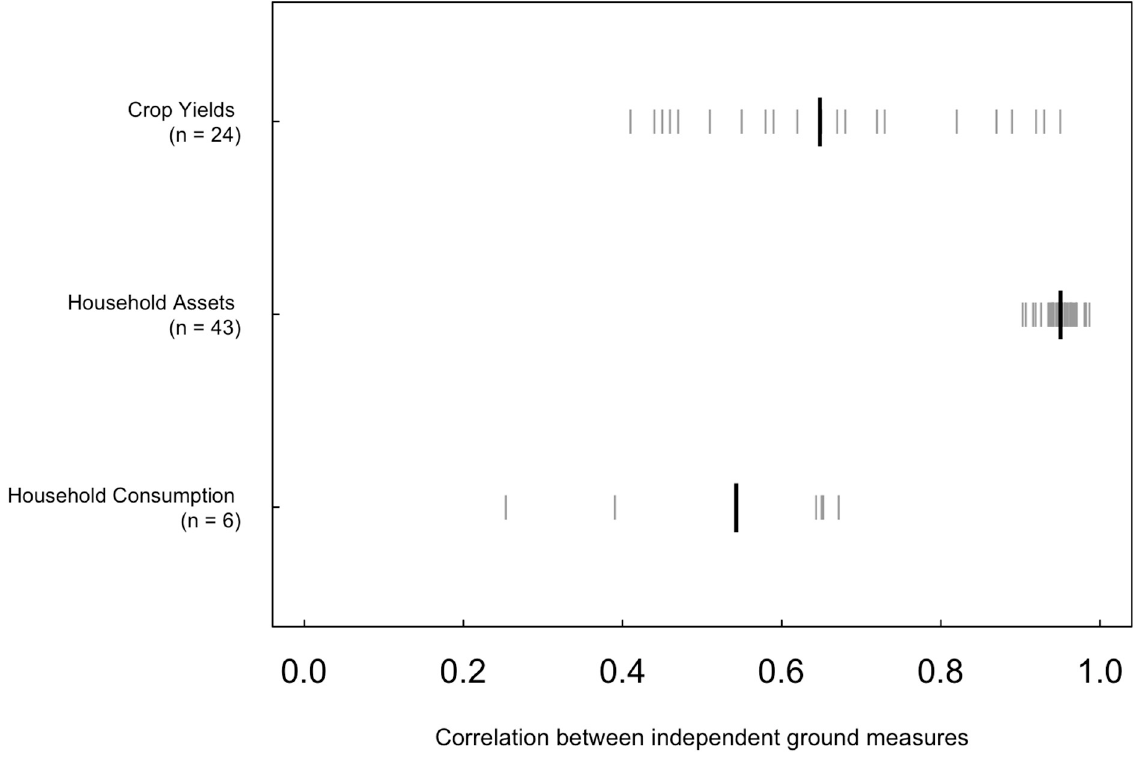
Figure 1. Noise in ground-based measures can lead to low correlations between independent measures in the same location. Gray lines show estimates of the correlation between two independent measures, with one line for each separate dataset, and black line shows the mean value across datasets. Individual studies and sources for crop yields are presented in Table S1. For household assets, we used data from DHS for 23 countries, with 1–4 years per country. For consumption estimates, we used data from LSMS for three countries, with two years per country. The mean number of fields for crop-cut studies was 145. The mean number of clusters for asset surveys was 462, with an average of 25 households per cluster. The mean number of clusters for consumption surveys was 161, with a mean of 10 households per cluster.